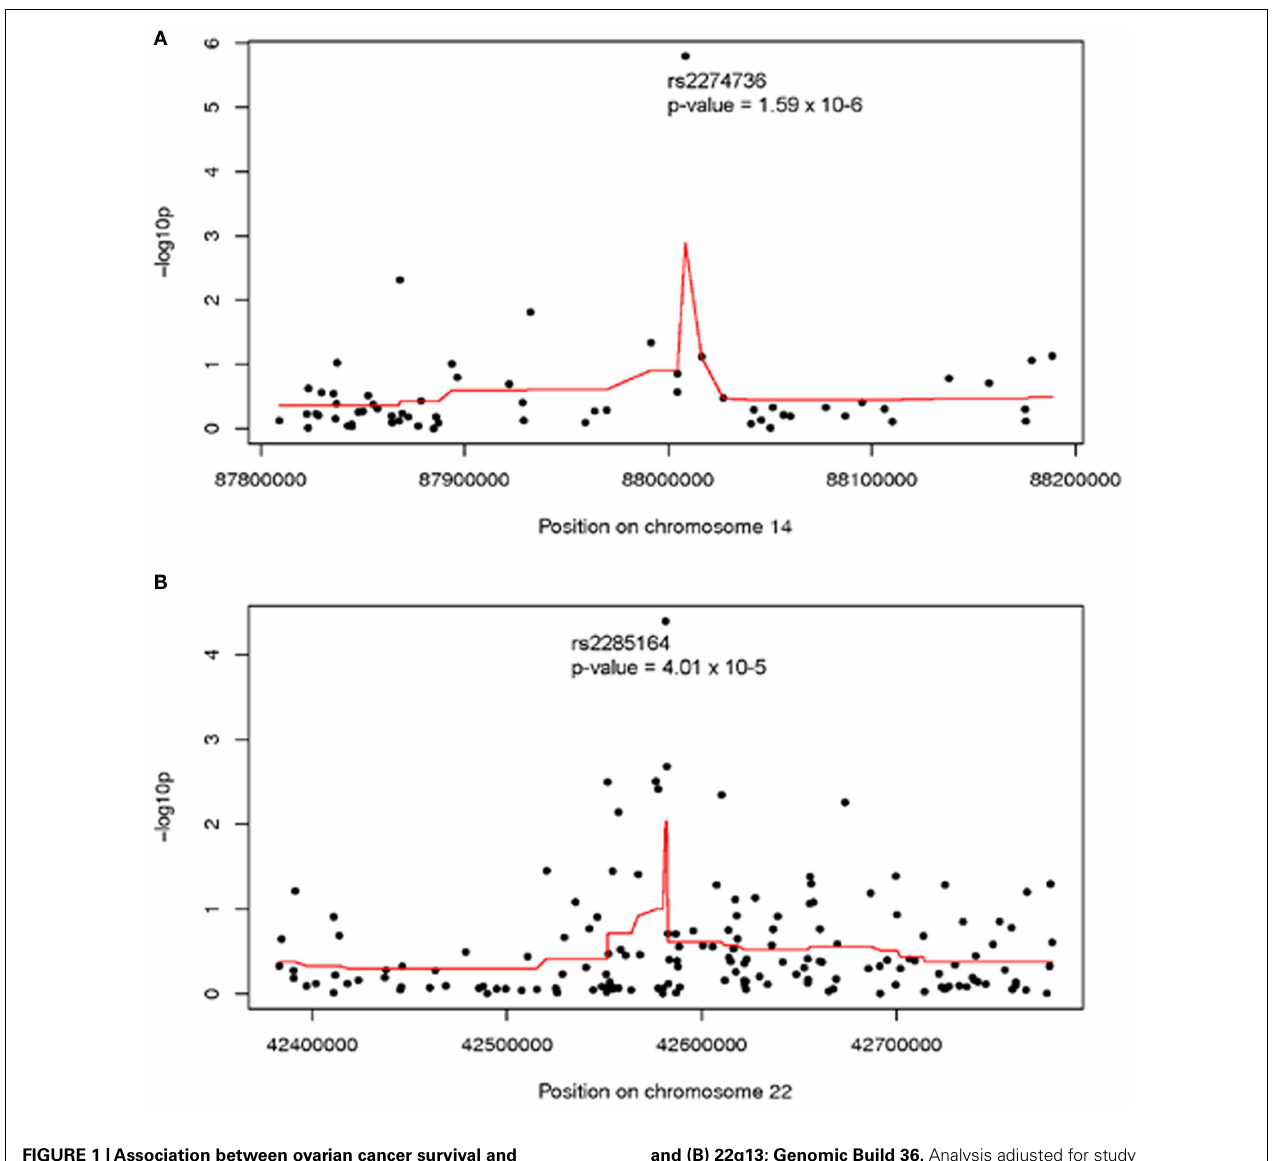
FIGURE 1 |Association between ovarian cancer survival and normalized intensities at individual markers (black dots) and smoothed regional association (red line) in (A) 14q31